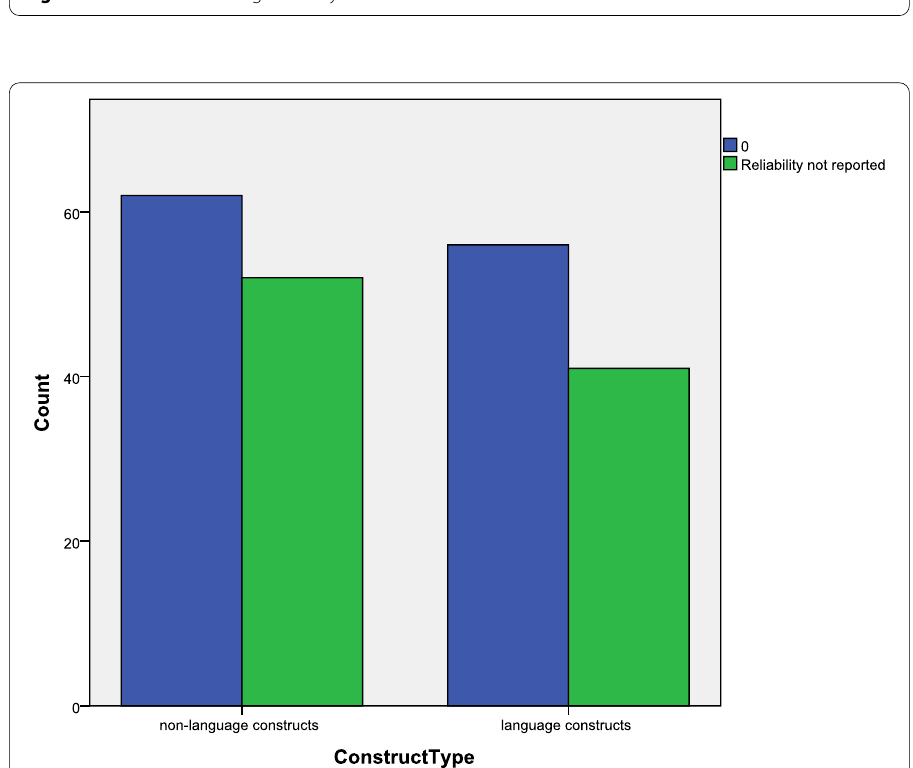
Fig. 3 Methods of estimating reliability